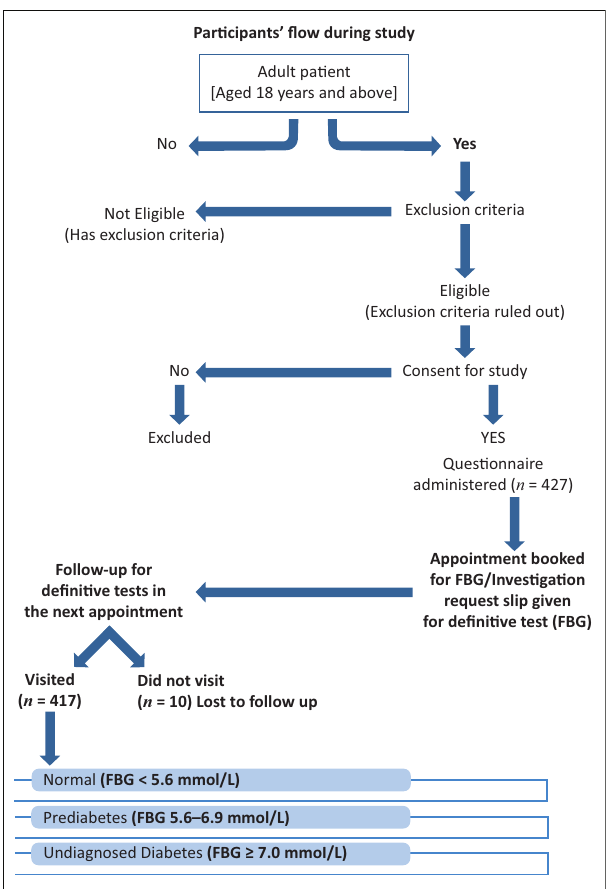
FIGURE 1: Participants’ flow during the